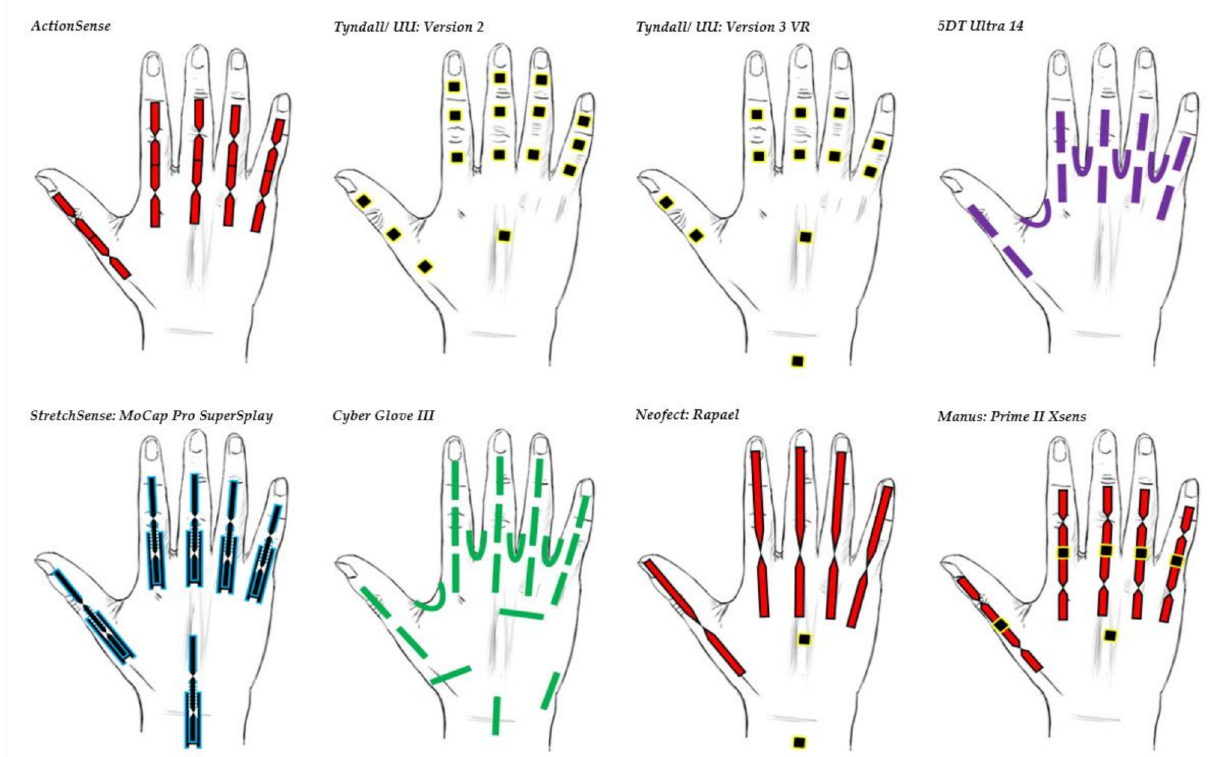
Figure 31. Modern commercialized and research smart